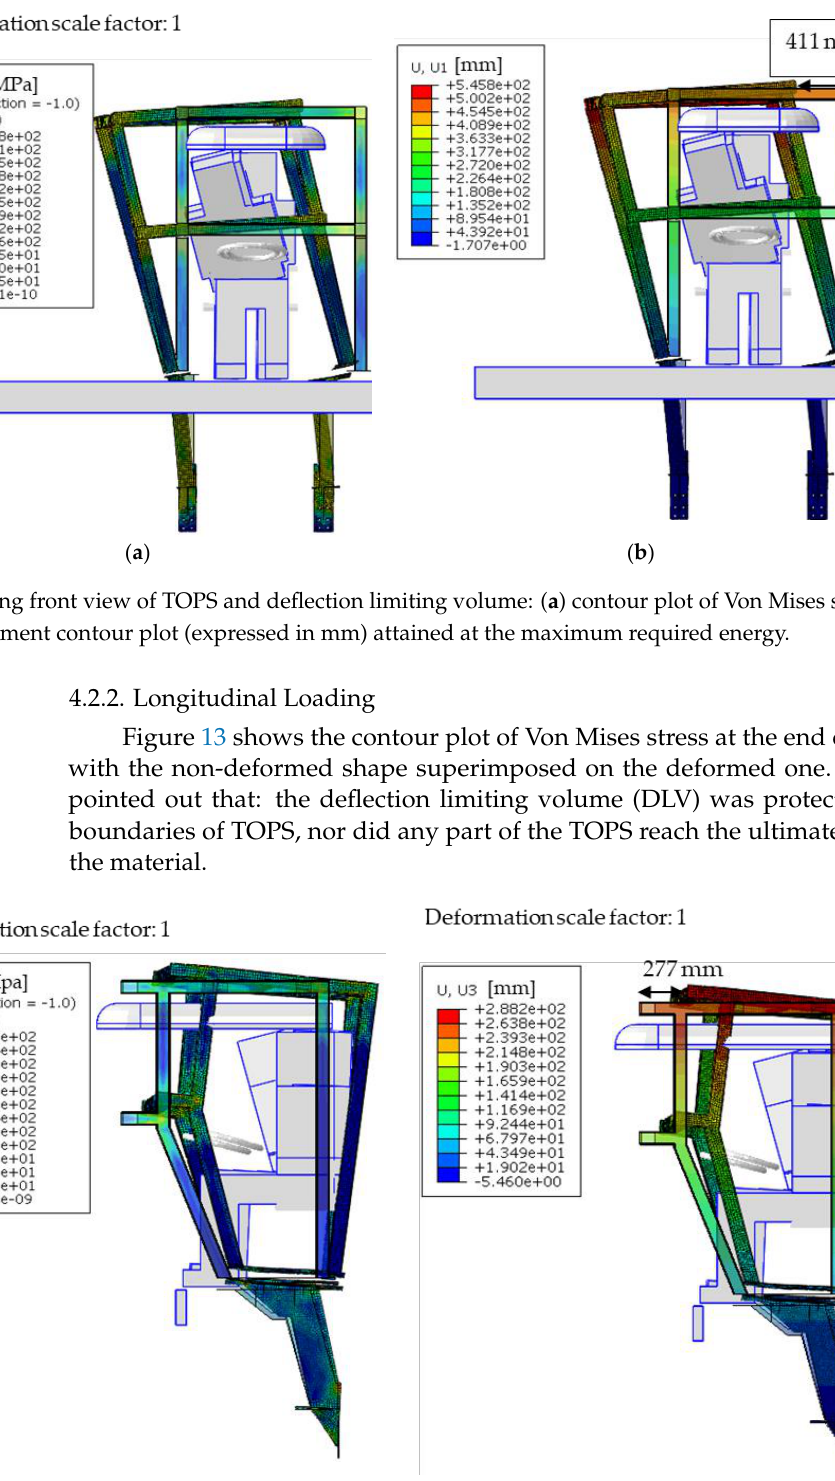
( b ) Figure 14. Permanent deflection (expressed in mm) of the ROPS structure after the side and longitudinal loadings: ( a ) front view; ( b ) top view.